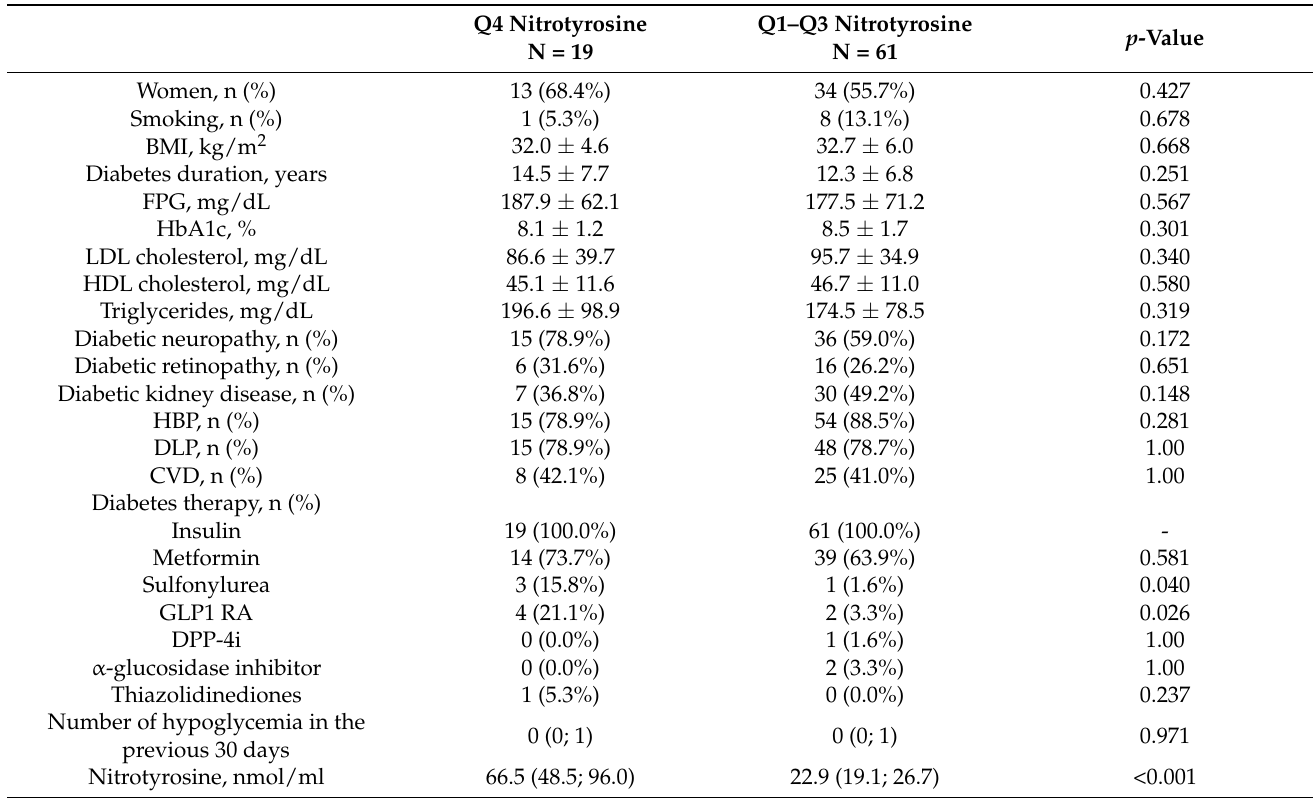
Table 1. Participants’ characteristics according to nitrotyrosine quartiles.